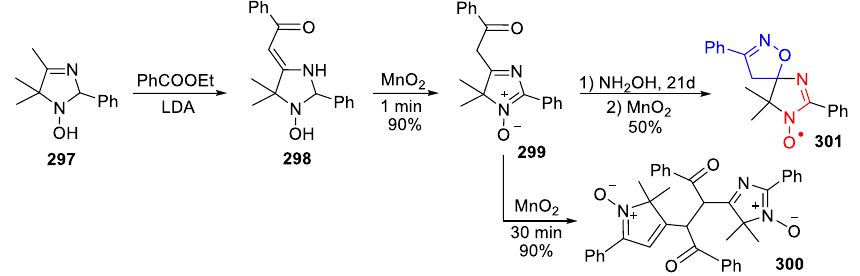
Scheme 53. Synthesis of β -spiro-conjugated SNR 301 .